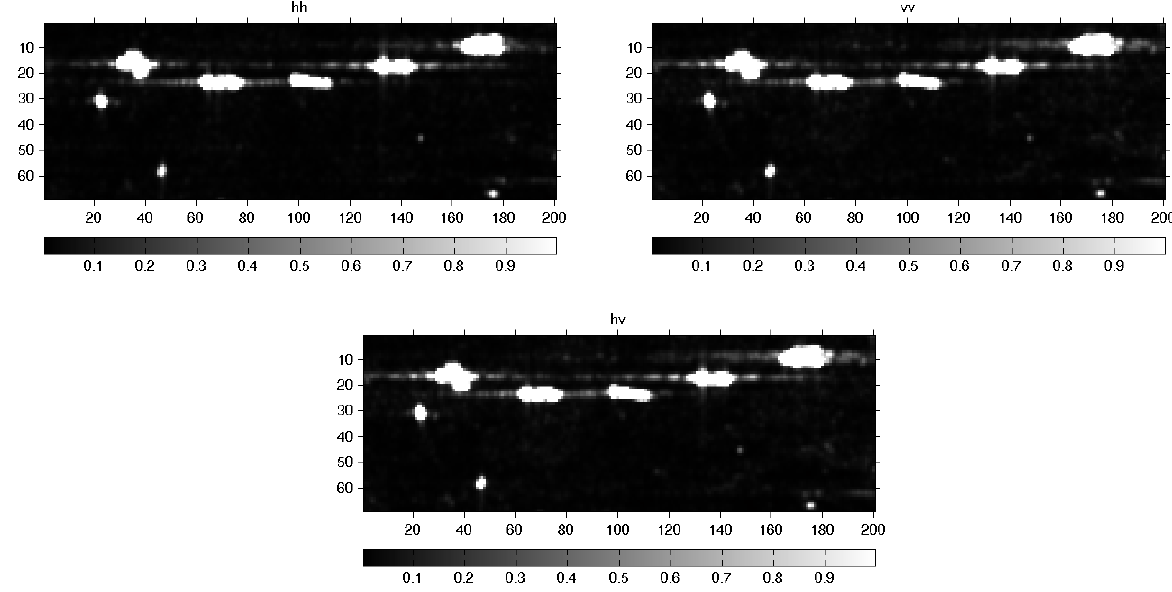
Figure 6. The HH,VV and HV polarization gray images of SIR-C/X